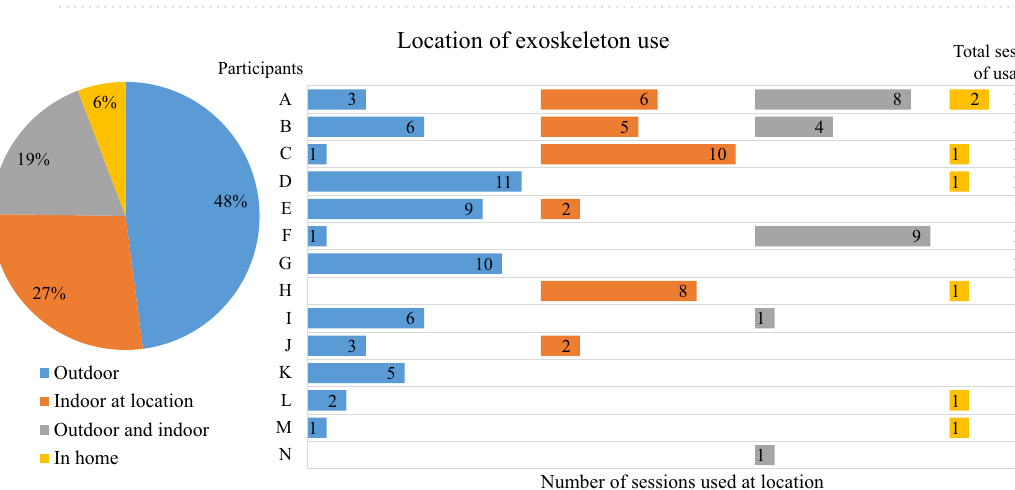
Figure 2. Purpose of exoskeleton use during the period of home and community use.